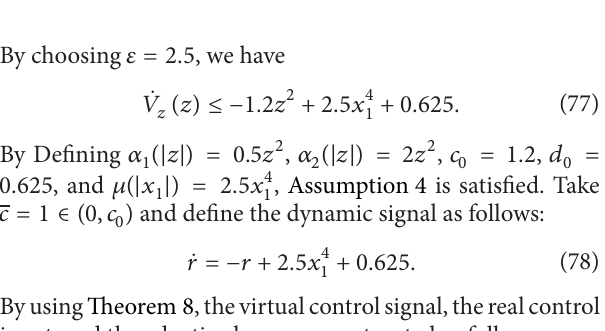
Figure 1: State variables 𝑥 1 and 𝑥 2